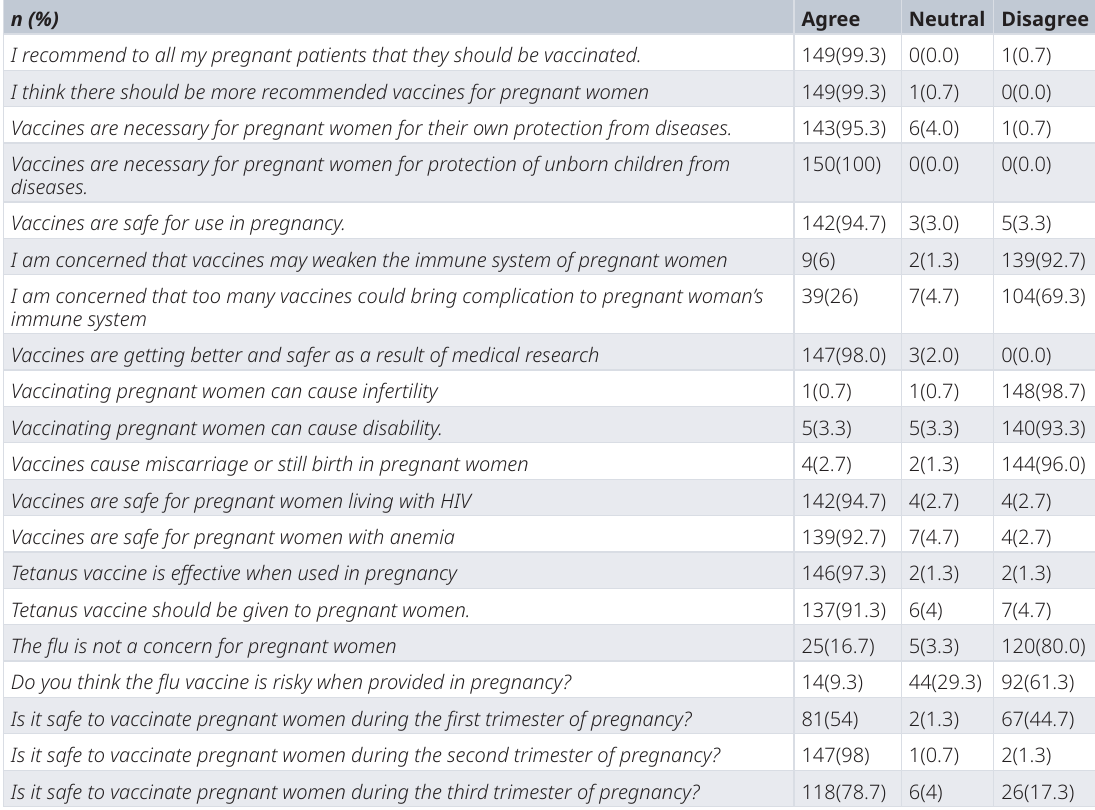
Table 2. Antenatal care (ANC) provider knowledge, attitudes and beliefs on vaccination. n (%) Agree